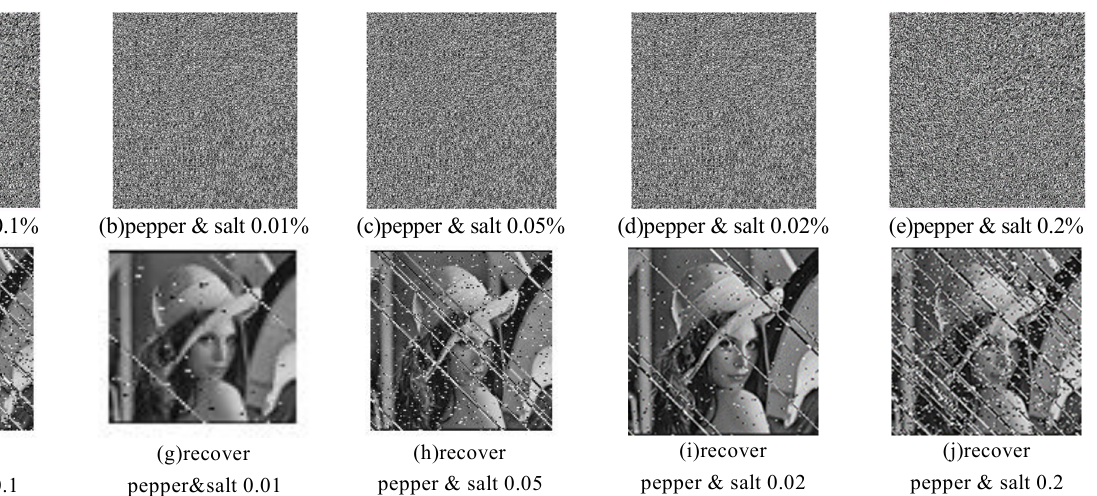
Figure 9. Data loss and recovery in different degrees.